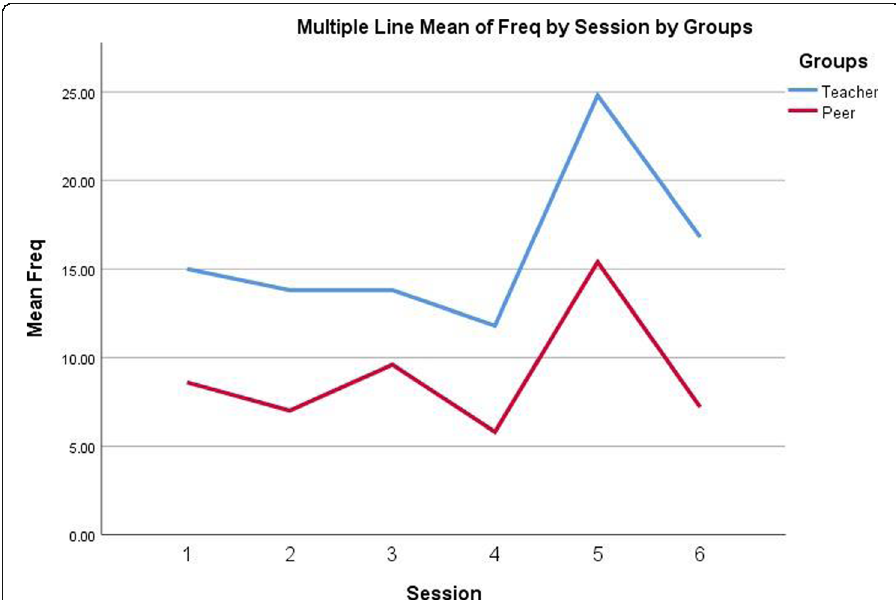
Fig. 4 Magnitude of TA and PA on narrative writings in